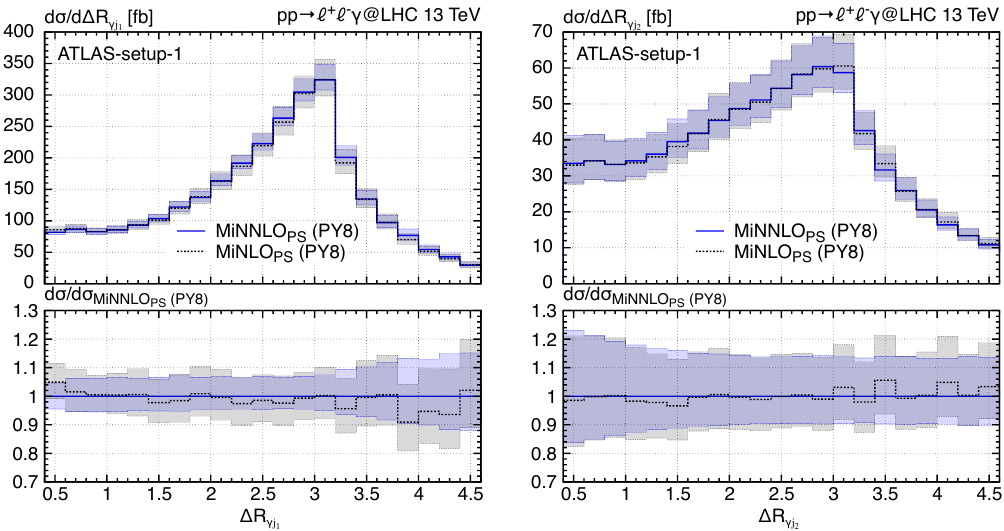
Figure 5. Distribution in the ∆ R separation between the photon and hardest jet (left plot), and between the photon and the second-hardest jet (right plot) for MiNNLO MiNLO 0 (black, dotted